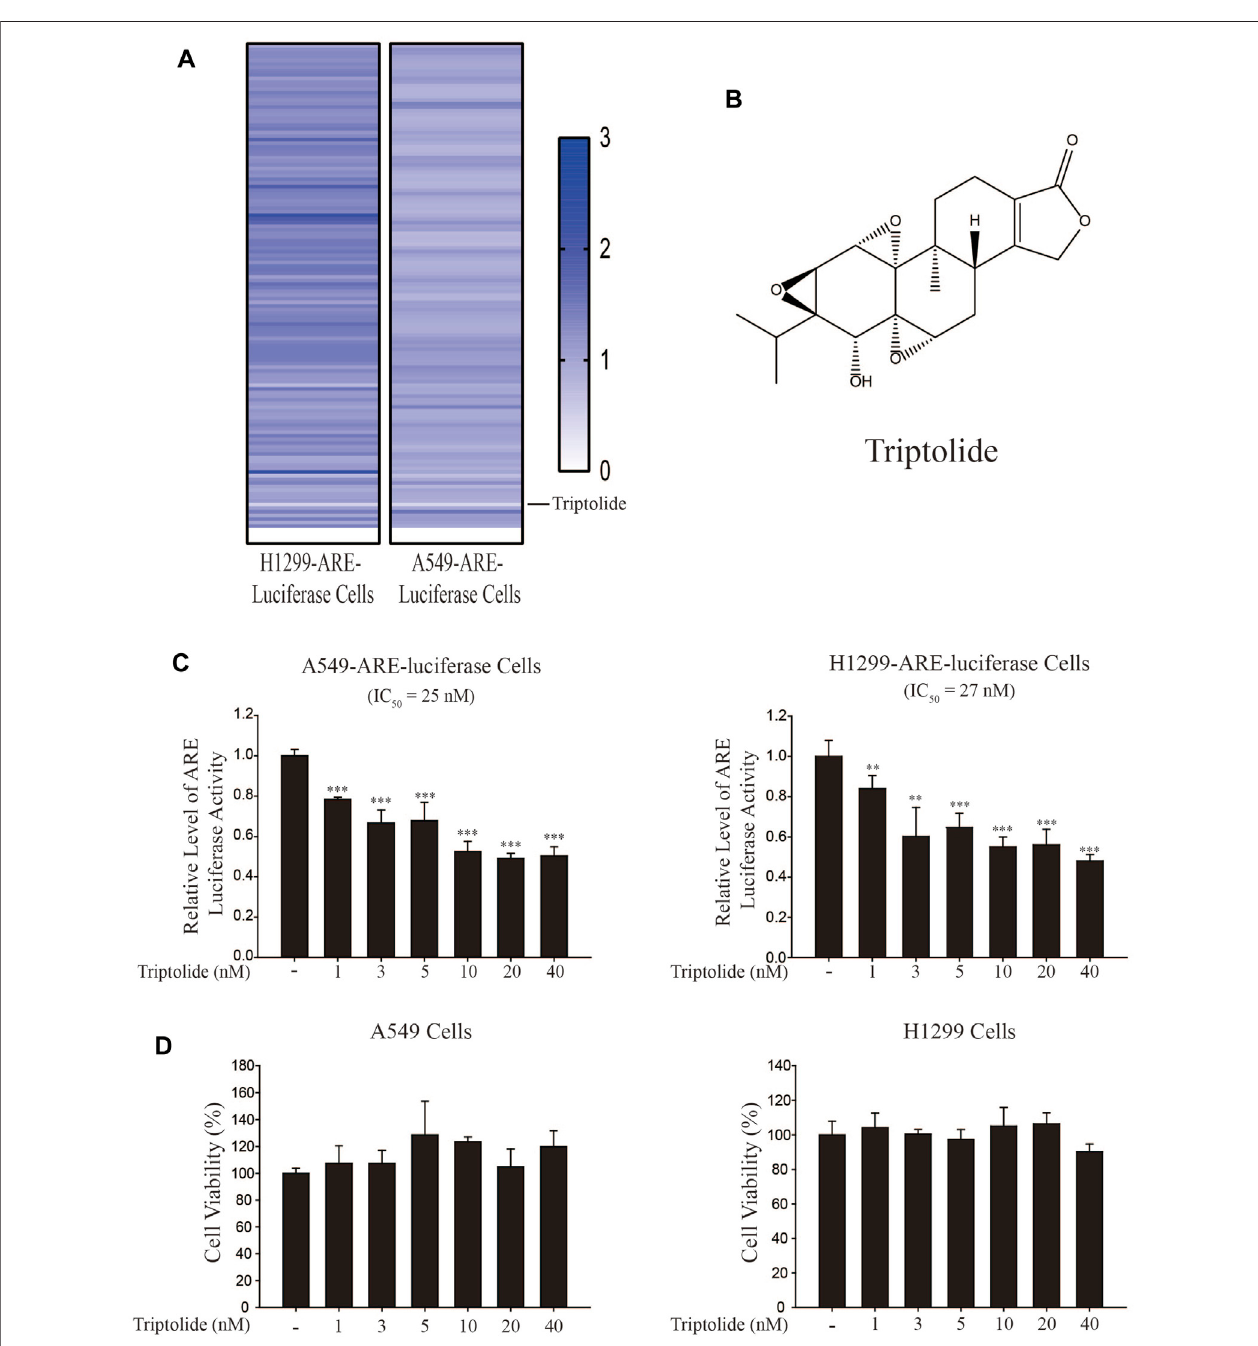
FIGURE 1 | Identi fi cation of triptolide as an NRF2 inhibitor. (A) Experimental setup for NRF2 inhibitor screening. Triptolide was identi fi ed as the strongest ARE- luciferase inhibitor in H1299-ARE-luciferase and A549-ARE-luciferase cells. (B) Chemical structure of triptolide. (C) Triptolide inhibits ARE-luciferase activity in A549- ARE-luciferasecells(LeftPanel)andH1299-ARE-luciferasecells(RightPanel)inadose-dependentmanner.A549-ARE-GFP-luciferaseandH1299-ARE-GFP-luciferase cells were seeded in 24-well culture plates (2 × 10 5 cells/well) and exposed to triptolide at multiple concentrations for 24 h. Cells were collected and the luciferase activity was measured. Asterisks indicate a statistical signi fi cance ( n (cid:2) 3): ** p < 0.01 and *** p < 0.001. (D) Triptolide does not affect the viability of A549 cells (Left Panel) and H1299 cells (Right Panel) at concentrations up to 40 nM. A549 and H1299 cells were seeded in 96-well culture plates (4 × 10 4 cells/well) and MTT assay was conducted ( n (cid:2) 3) after triptolide was added for 24 h.